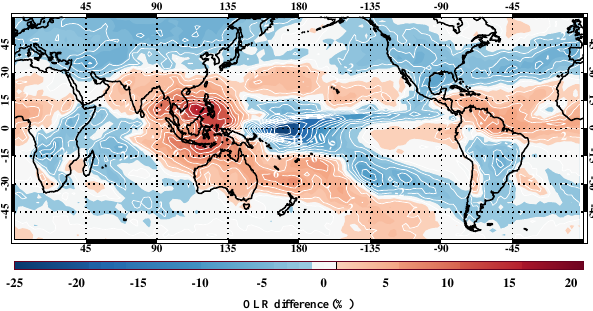
Figure 8. Difference in the outgoing longwave radiation (OLR) for months with strong El Niño conditions minus months of strong La Niña conditions from 2005–2013. The differences are expressed as percent of annual mean OLR. Thin white lines are incremented ev- ery 2%.